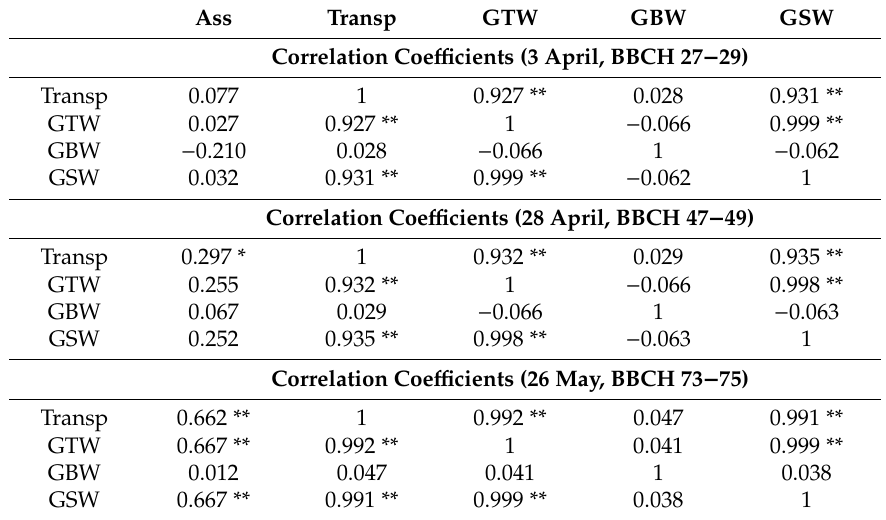
Table 3. Pearson correlation coe ffi cient values between assimilation parameters in winter barley (2020, Debrecen).